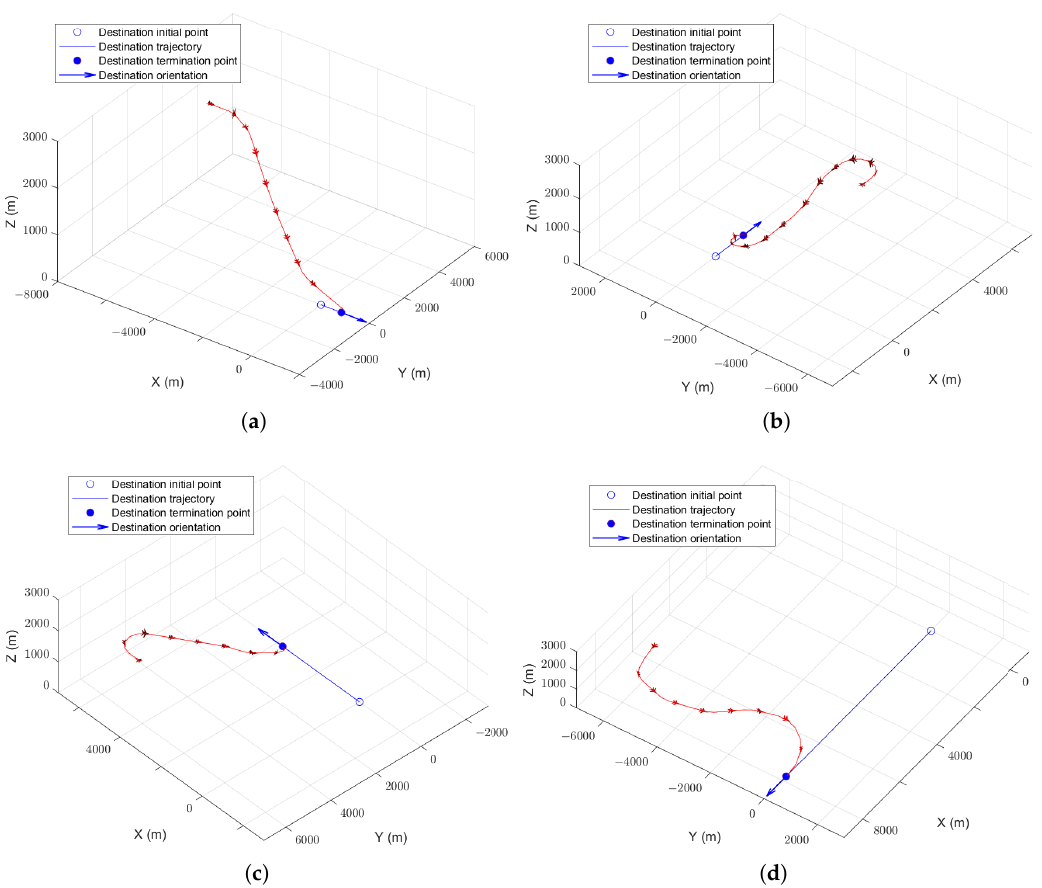
Figure 8. Trajectories in uniform-motion destination scenario: destination speed of ( a ) 10 m/s, ( b ) 20 m/s, ( c ) 50 m/s and ( d ) 100